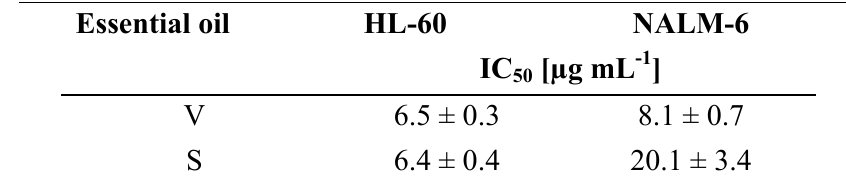
Table 3. Cytotoxic activity of S. sclarea essential oils. IC MTT